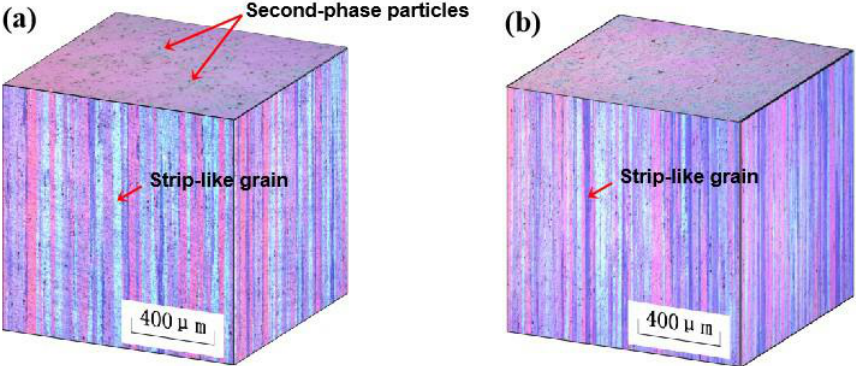
Figure 9. Three-dimensional micrographs of 2A90 alloy after T6 treatment. ( a ) Conventional DC casting; ( b ) LFEC with 10 Hz / 150 A.